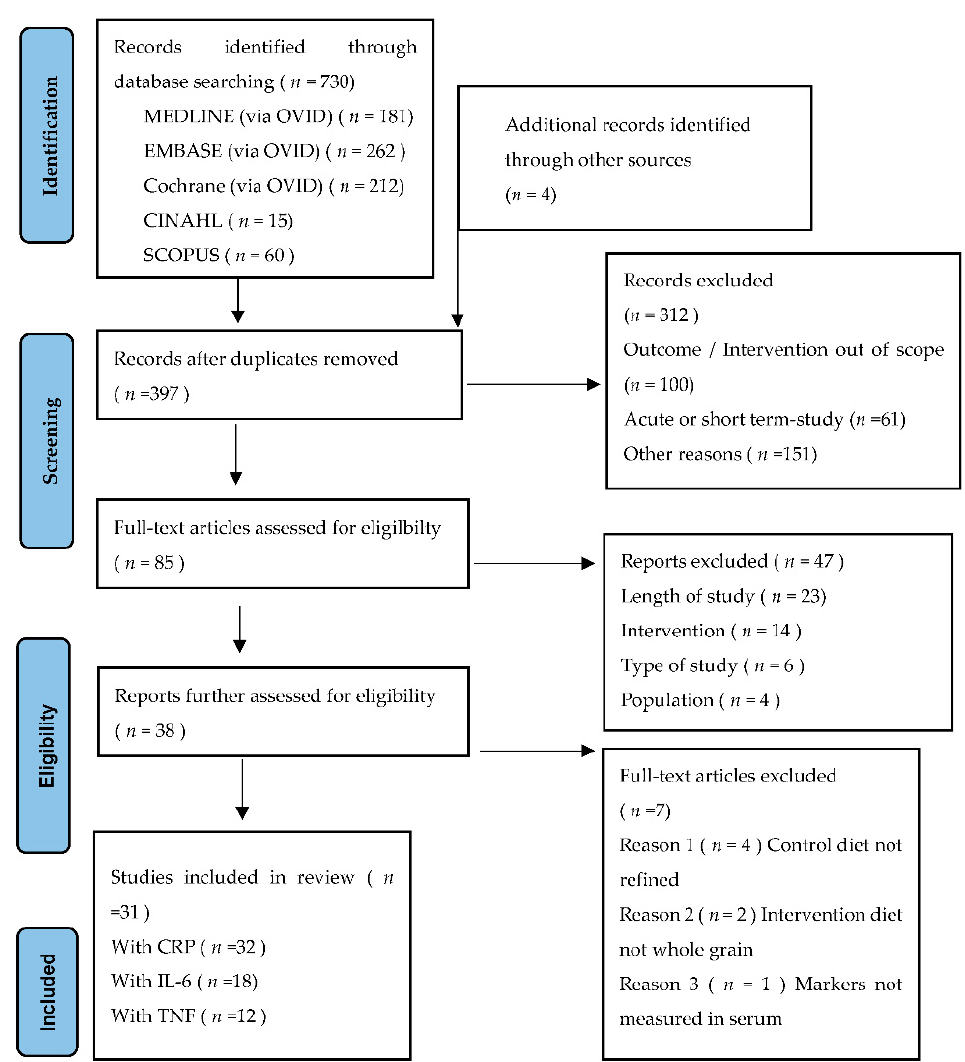
Figure 1. Preferred Reporting Items for Systematic Reviews and Meta-Analysis (PRISMA) flow diagram for study selection.